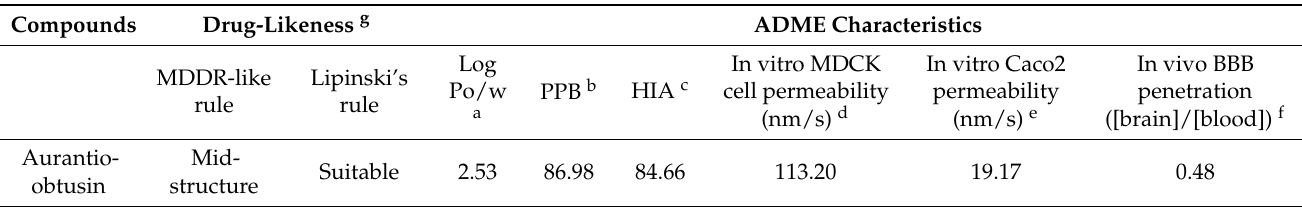
Table 3. Drug-likeness and absorption, distribution, metabolism, and excretion (ADME) characteristics as predicted by